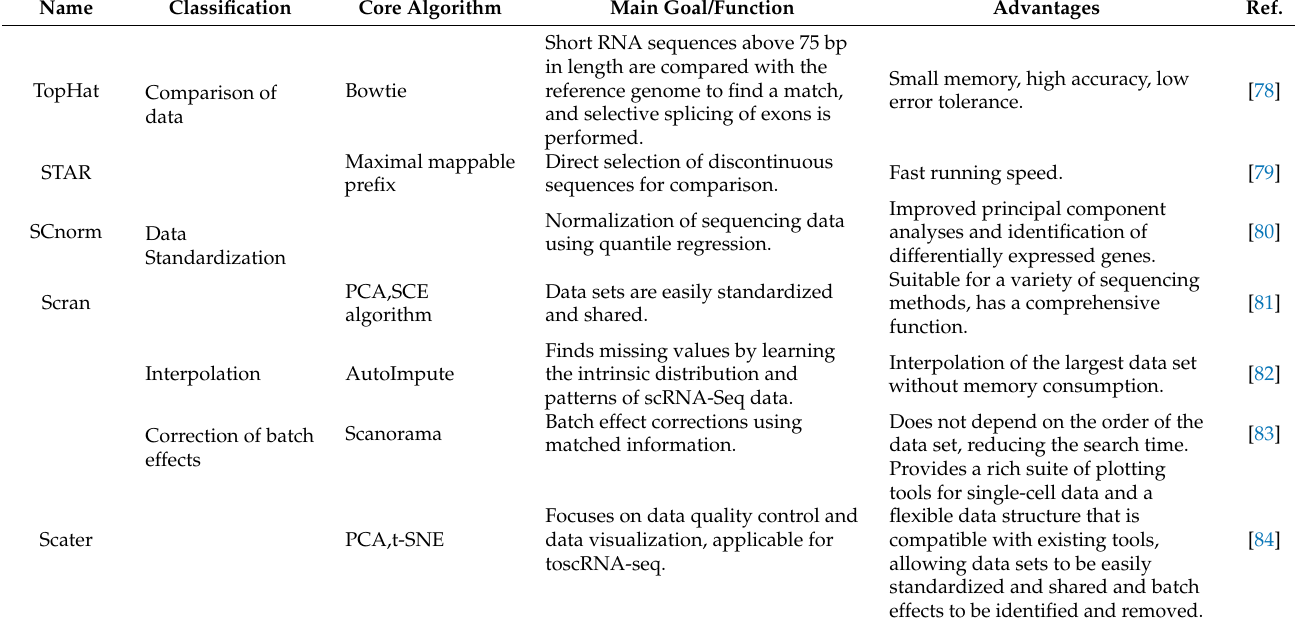
Table 8. The methods and tools commonly used for SCS analysis and